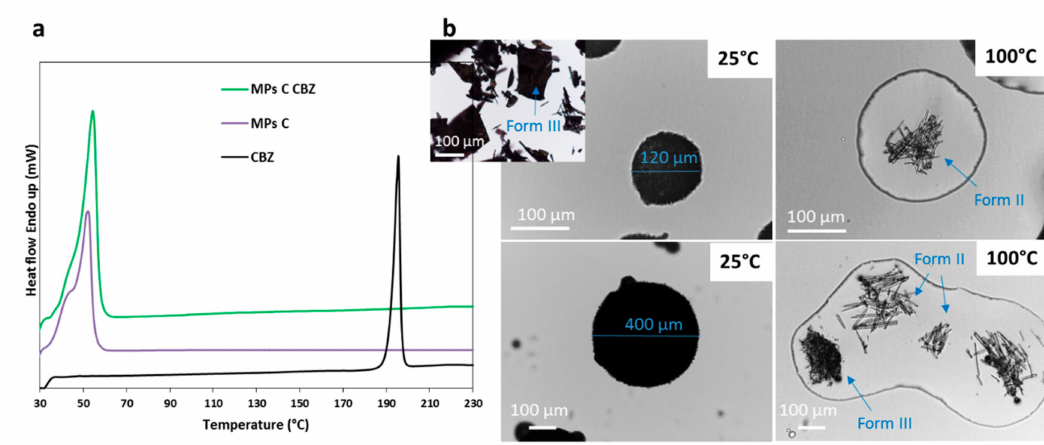
Figure 4. ( a ) DSC curve of CBZ, unloaded MPs C and MPs C CBZ; ( b ) HSM analysis of CBZ (small image on the left at 25 ◦ C) and MPs C CBZ at 25 ◦ and 100 ◦ C of small size (on the top) and large size